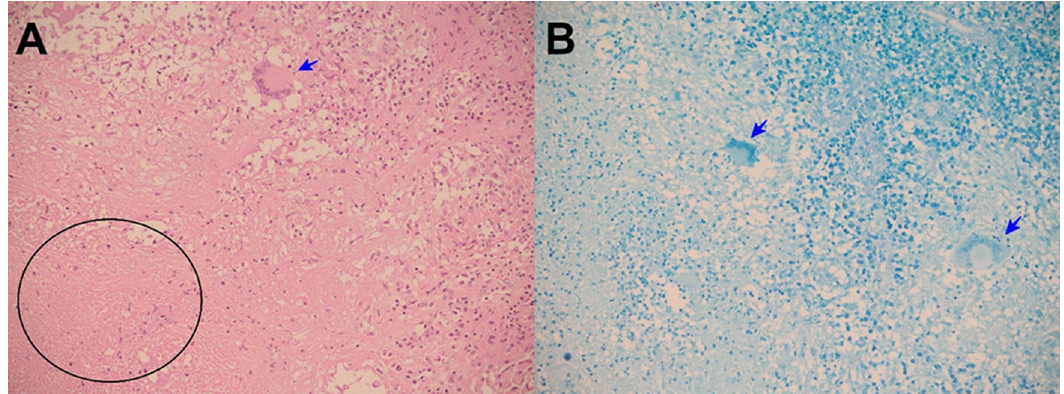
Figure 3. A: Electronic microphotography (x40) showing small bowel with chronic granulomatous inflamma- tion, caseous necrosis (black circle) and Langhans multinucleated giant cells (blue arrows). B: Electronic microphotography(x40)showingLanghansmultinucleatedgiantcells(bluearrows);Ziehl-Neelsensmearfor Acid Fast Bacilli was